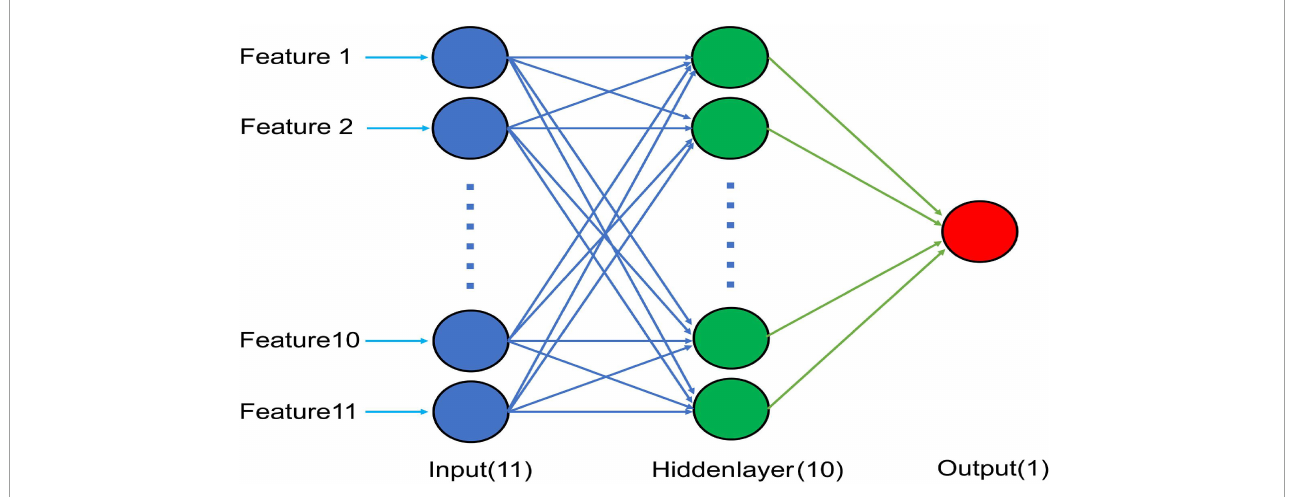
FIGURE1 Schematic diagram of the optimal BP neural network model with 11 input nodes, 10 nodes in a hidden layer, and a single output node.